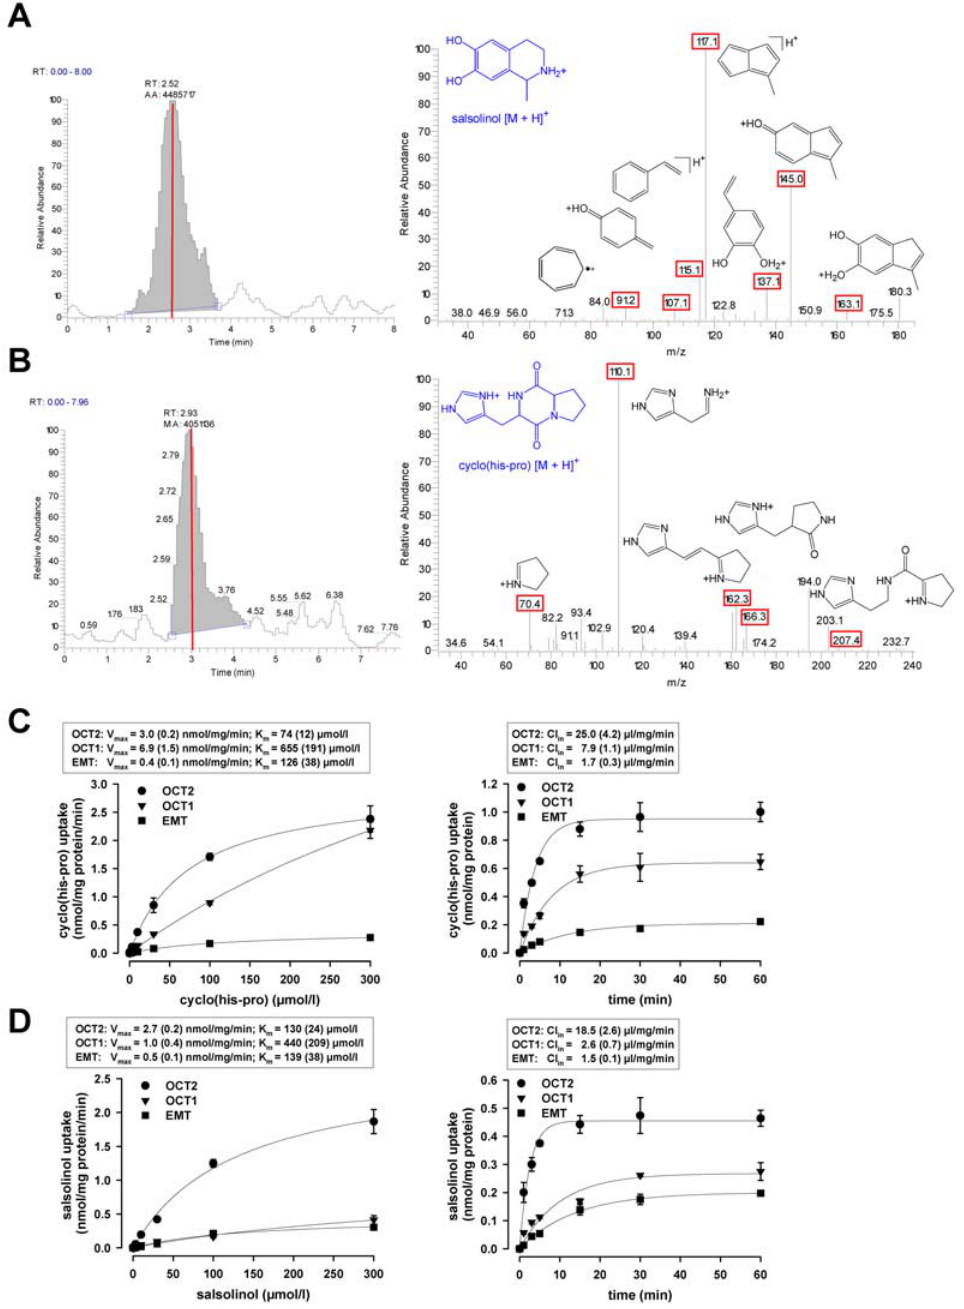
Figure 1. Identification and transport kinetic characterization of cyclo(his-pro) and salsolinol as endogenous substrates of the organic cation transporter OCT2. (A and B) Chromatograms and corresponding spectra of ESI-MS-MS fragmentation of the molecular ions [M + H] + at m/z 180 and 235 derived from lysates of OCT2-transfected HEK-293 cells versus empty vector transfected HEK-293 cells after 30 min of incubation with 100% fetal bovine serum (pH 7.4, 37 u C) following 60 min preincubation in buffer solution. Specific fragment masses are indicated in red and assigned to the proposed fragment ion structures; the parent ions are shown in blue. (C and D) Concentration dependence, maximal transport rate V max (mean (s.e.m.)) and Michaelis-Menten constant K m (mean (s.e.m.)) of specific uptake of cyclo(his-pro) or salsolinol into HEK-293 cells transfected with OCT2 or the related cation transporters OCT1 and EMT after 1 min of loading (left panel); time dependence and influx clearance Cl in (mean (s.e.m.)) of specific uptake after incubation with 10 m mol/l of cyclo(his-pro) or salsolinol (right panel) (n=3 independent experiments each). N-methylation of intracellular salsolinol was negligible (maximal 2.5% of salsolinol concentration after 60 min of incubation).